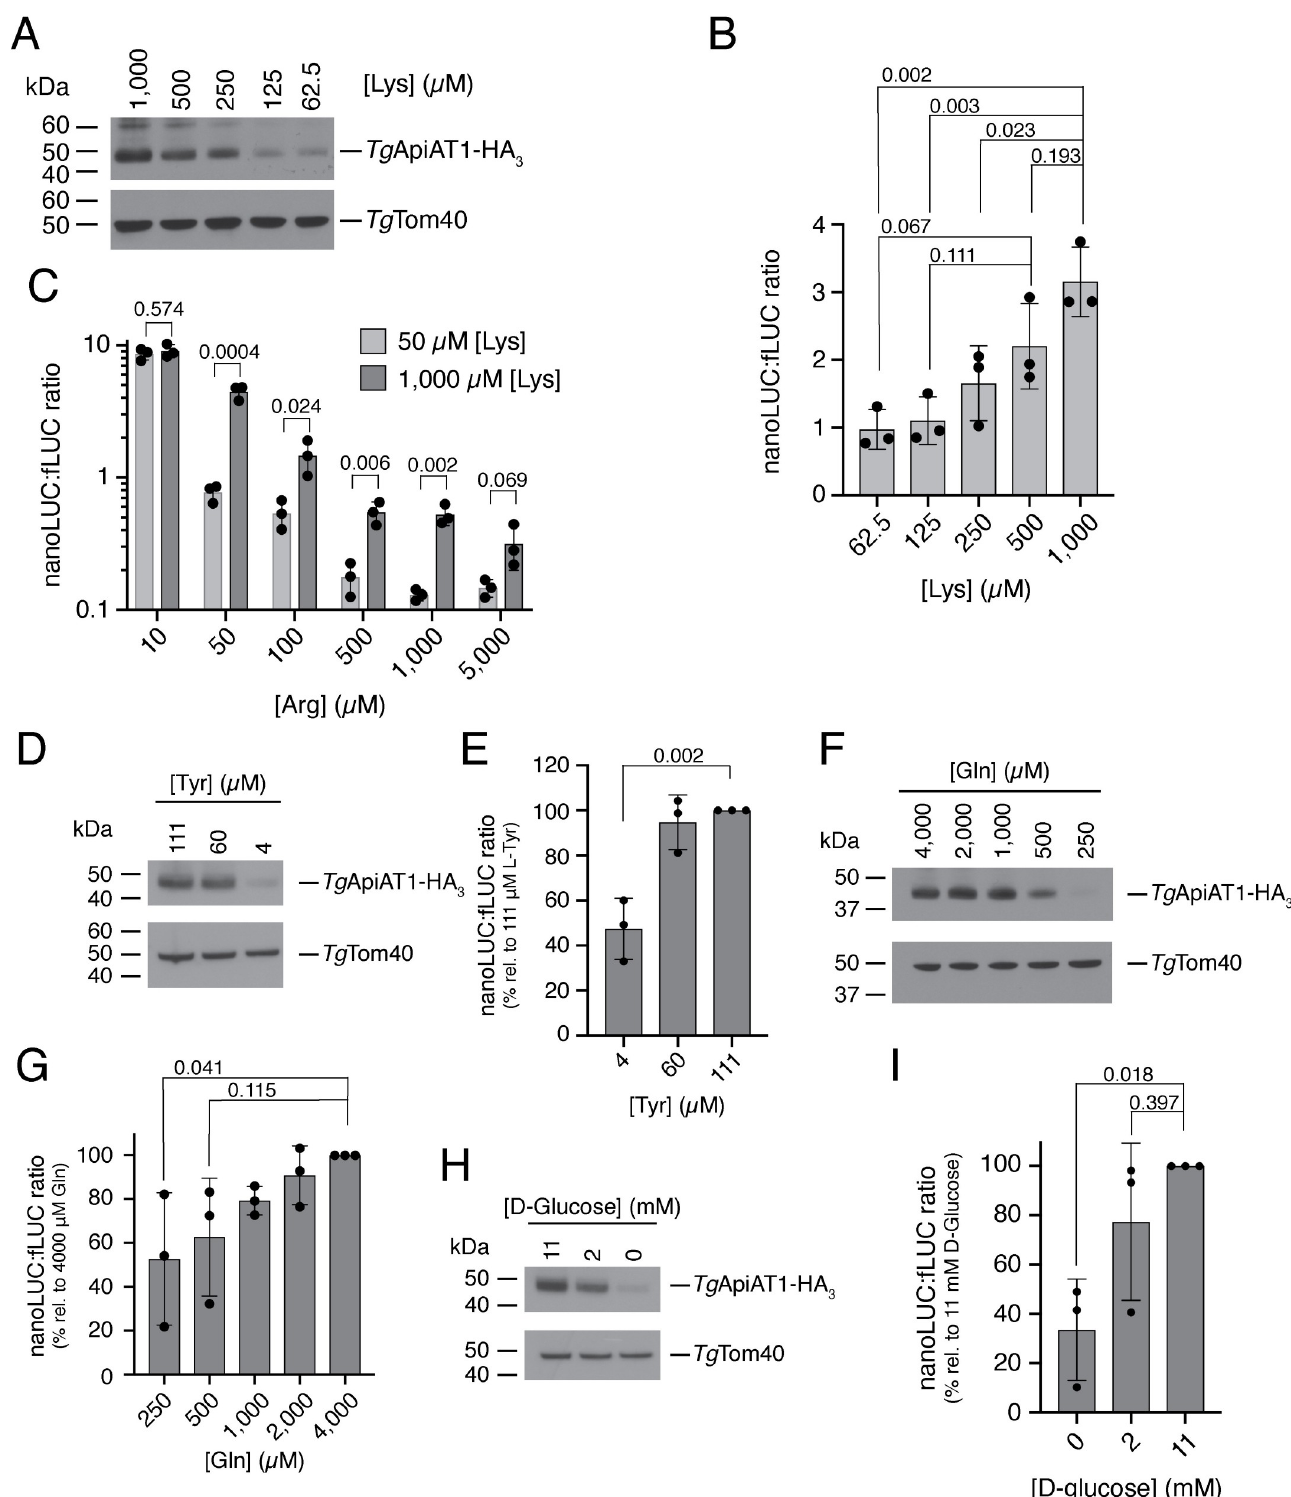
Fig 3. Tg ApiAT1 regulation is mediated by a range of nutrients. ( A , D , F , H ) Western blots of Tg ApiAT1-HA 3 in parasites grown at a range of ( A ) [Lys], ( D ) [Tyr], ( F ) [Gln], or ( H ) [D-glucose] in the growth medium. Tg Tom40 is a loading control. Data are representative of three independent experiments. ( B ) nanoLUC:fLUC ratio in parasites grown in media containing a range of concentrations of Lys. Data represent the mean ± SD from three independent